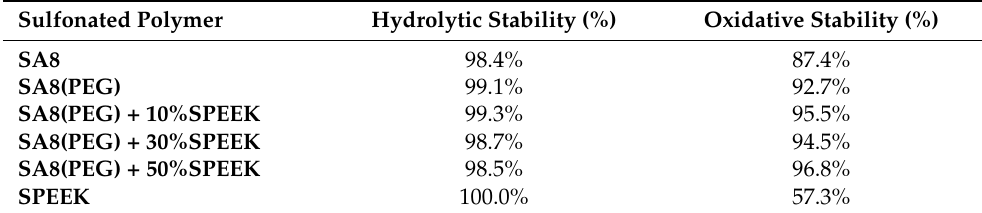
Table 9. The chemical stability of SA8 blended with PEG and sPEEK.